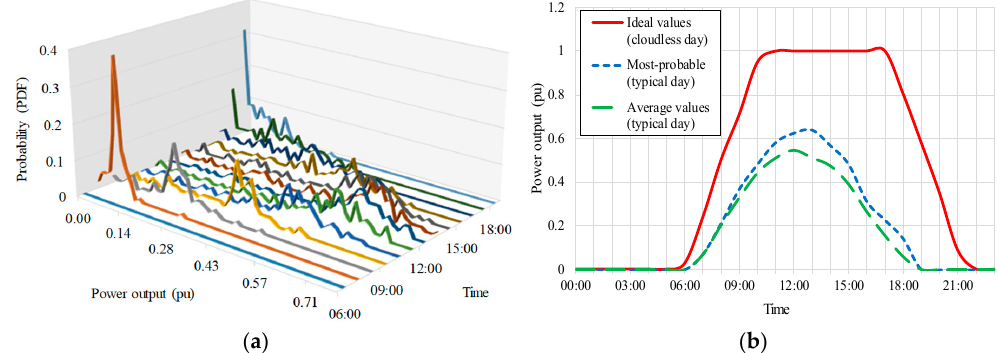
Figure 6. PV power output modelling: ( a ) Probabilistic variations of hourly output power; ( b ) Temporal power output variations for different power output models.